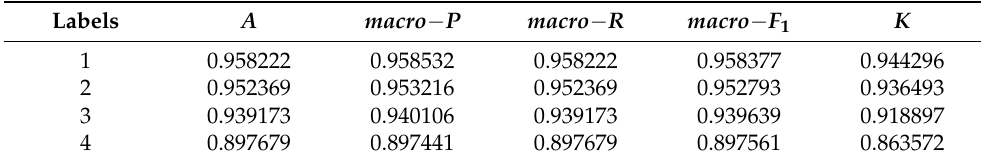
Table 4. Statistical table of model numerical indicators of different labels.